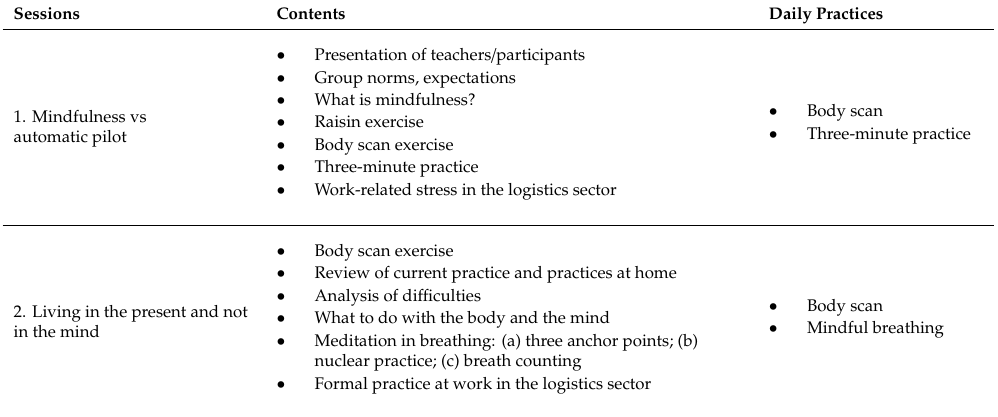
Table 1. Workplace-adapted mindfulness-based programme for the logistics sector